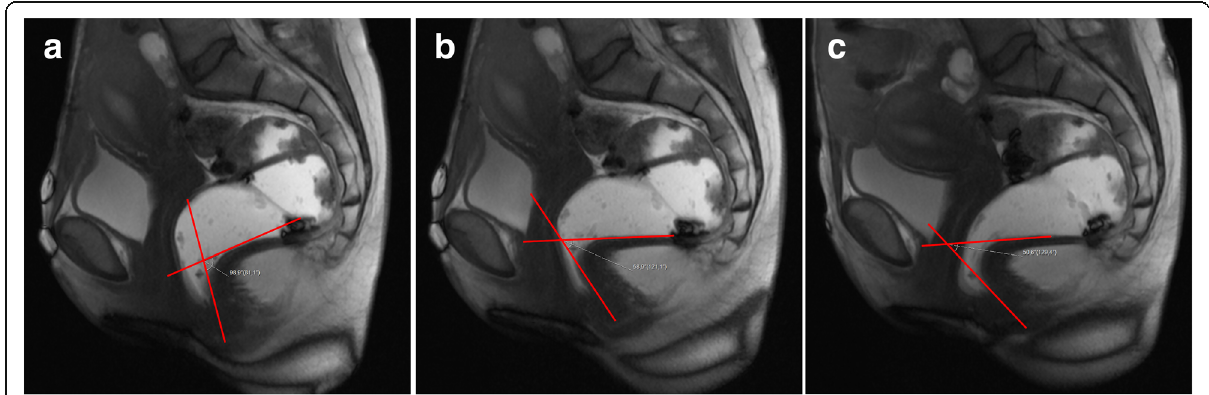
Fig. 21 Spastic pelvic floor syndrome. ( a , b , c ) Sagittal midline TrueFISP images of a 39-year-old patient at rest (a) , during squeezing (b) and during evacuation (c) . Note in (a) the ARA is 99° (elevated basal tonus), associated with the reduction of the ARA during defecation ( c ) with 50°, corresponding to a paradoxical contraction of the puborectalis muscle